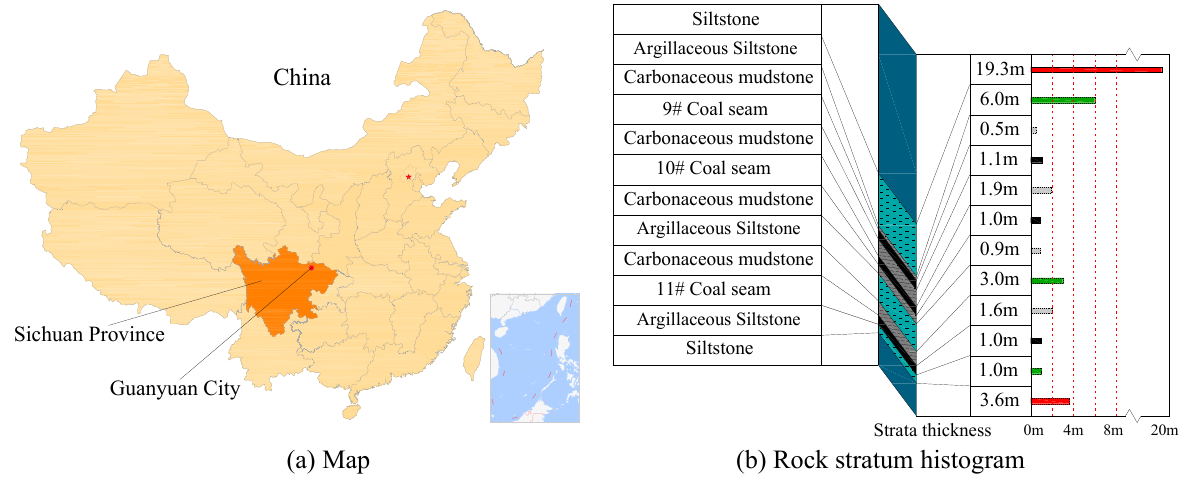
Figure 1. Coal mine location and coal seam histogram.